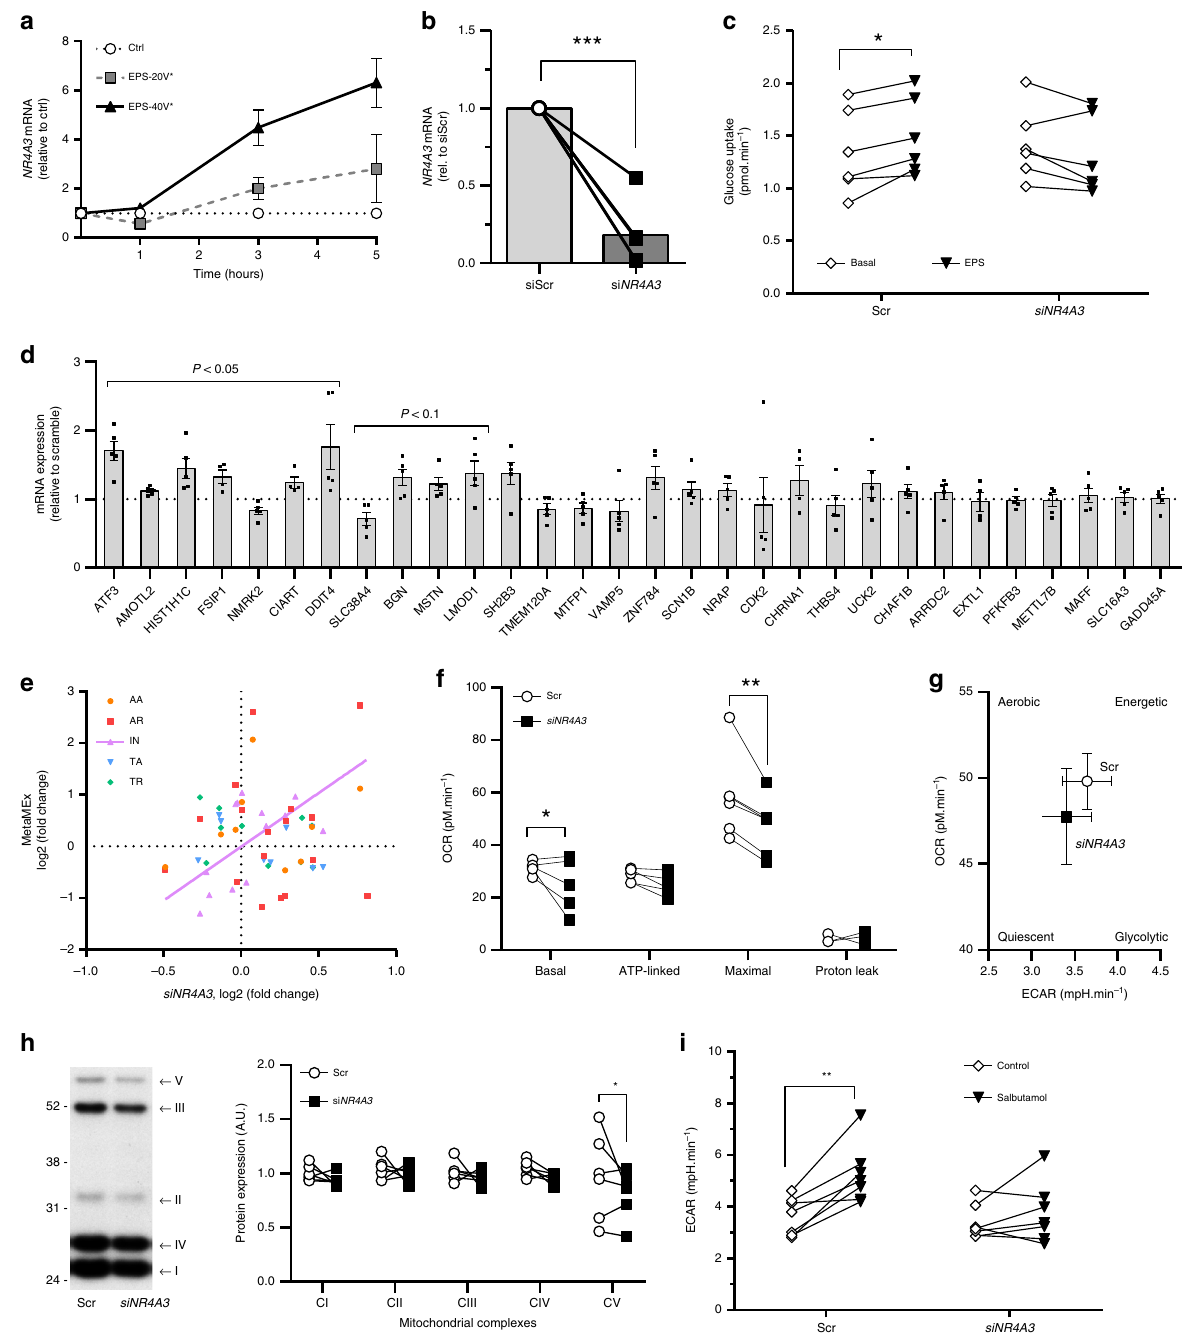
Fig. 5 NR4A3 regulates the metabolic response to in vitro exercise. a N R4A3 responds in a time- and intensity-dependent manner to electrical pulse stimulation. Data are mean ± SEM, n = 3 biologically independent primary cells from different donors, two-way ANOVA (time, intensity), *overall effect p < 0.05. b Silencing ef fi ciency using siRNA against NR4A3, n = 4 biologically independent primary cells from different donors, individual paired t -test vs scramble, *** p < 0.001. c Electrical pulse stimulation-induced glucose uptake is abolished after NR4A3 silencing. Two-way ANOVA (si NR4A3 , EPS), n = 6 biologically indepe n dent primary cells from different donors, * p < 0.05. d Silencing NR4A3 using siRNA modi fi es the mRNA levels of exercise- and inactivity-responsive genes. Data are mean ± SEM, n = 4 biologically independent primary cells from different donors, individual paired t -test vs scramble. e Silencing of NR4A3 correlates with inactivity observed in MetaMEx. f Reduction of NR4A3 level impairs basal and maximal oxygen consumption measured by Seahorse XF analysis. Individual paired t -tests vs scramble, n = 5 biologically independent primary cells from different donors, * p < 0.05, ** p < 0.01. g Silencing of NR4A3 leads to a drift of muscle cells towards a more quiescent phenotype. Data are mean ± SEM. h Silencing of NR4A3 decreases the abundance of mitochondrial complexes. Representative blot and quanti fi cation, n = 6 biologically independent primary cells from different donors, two-way ANOVA, signi fi cant effect of silencing ( p = 0.018), * p < 0.05 uncorrected Fisher ’ s LSD post-test. i The increase in glycolysis (ECAR) induced by beta-adrenergic stimulation (20 µ M salbutamol for 3 h) is impaired in the absence of NR4A3 . SeaHorse XF experiment, two-way ANOVA (si NR4A3 , Salbutamol), n = 7 biologically independent primary cells from different donors, ** p < 0.01. AA: acute aerobic, AR: acute resistance, IN: inactivity, TA: training aerobic, TR: training